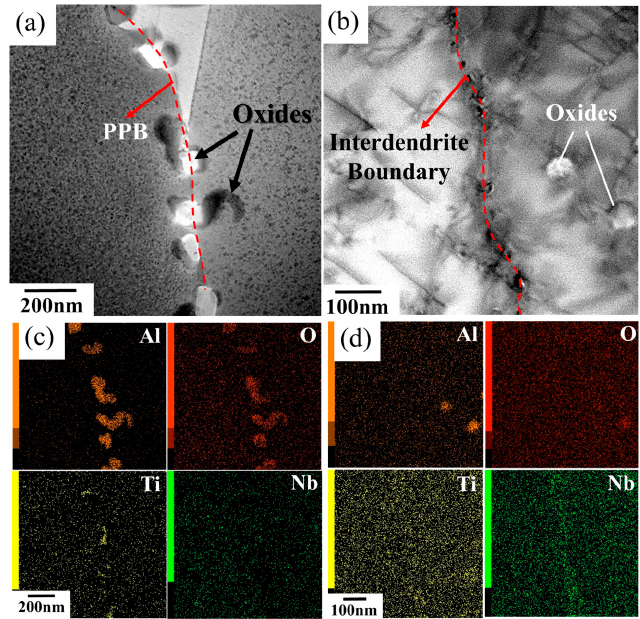
Figure 5. Transmission electron microscopy (TEM) bright field micrograph of ( a ) as-HIPed specimen and ( b ) as-built SLM specimen; Digital maps of energy dispersive spectroscopy (EDS) analysis showing distribution of Al, O, Ti and Nb elements within ( c ) as-HIPed specimen and ( d ) as-built SLM specimen.